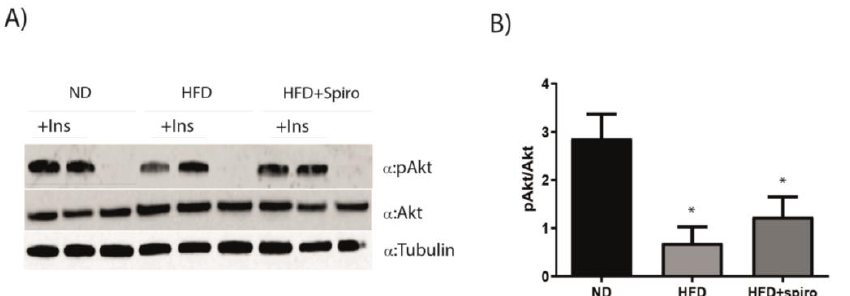
Figure 3. Mice fed an HFD displayed altered insulin signaling, but Spiro treatment does not improve insulin sensitivity in obese mice. ( A ), representative immunoblots of Akt activation analysis in GA (n = 10). ( B ), distribution graphs of the densitometric scanning analyses performed by ImageQuant TL software by using α-tubulin as loading control. Akt’s phosphorylated form was normalized in comparison with its total form. * p < 0.05 vs. ND. Values are expressed as means ± SEM.